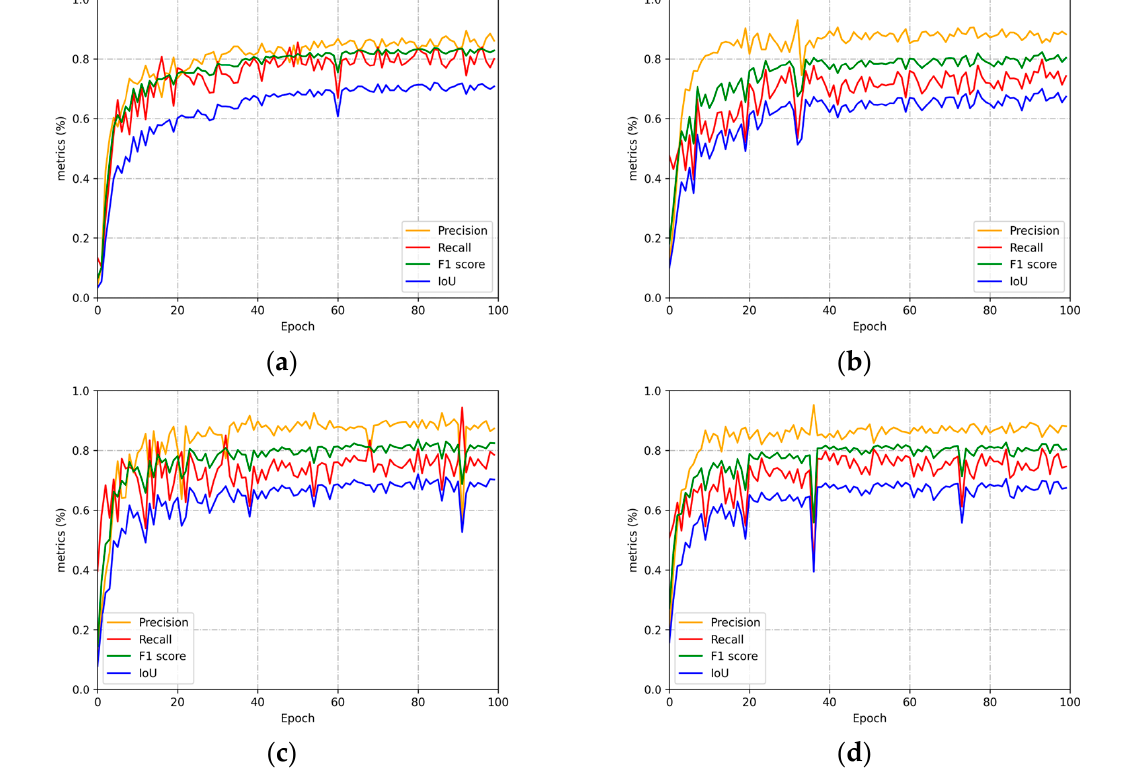
Figure 4. The metrics Precision, Recall, IoU, and F1 score as obtained from U-Net for different backbones: ( a ) vgg16, ( b ) resnet152, ( c ) densenet201, ( d ) inceptionv3. U-Net-vgg16, Linknet-vgg16, and FPN-vgg16 all performed well without noise in the